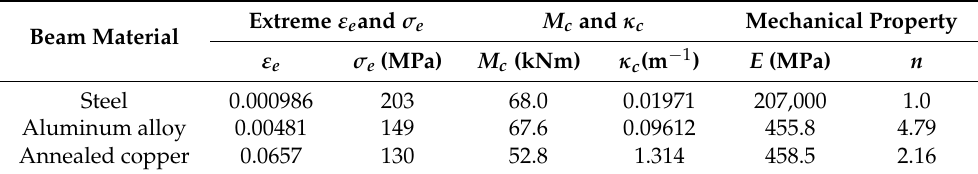
Table 1. Comparisons of extreme strain ε e and stress σ e for the three beam